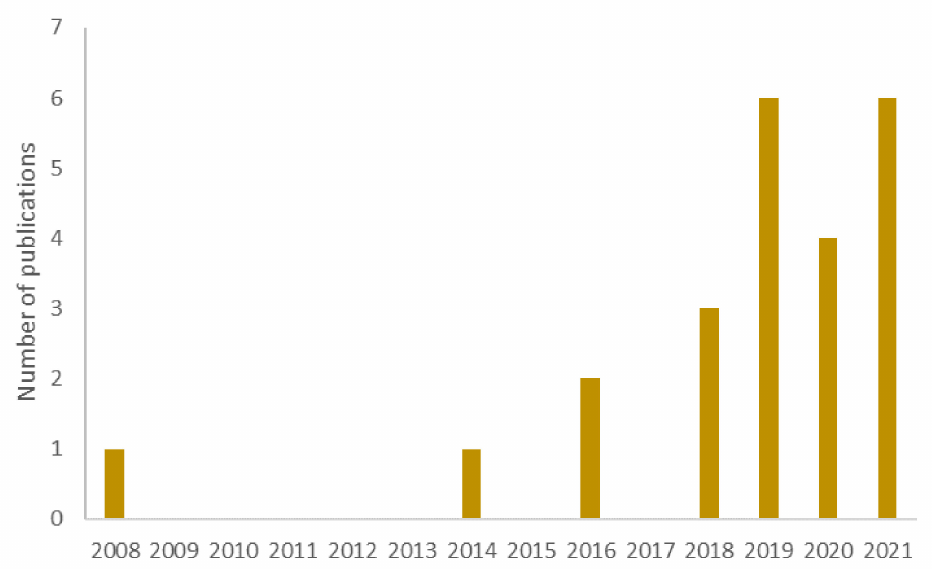
Figure 11. Number of publications based on UAV data in the analyzed multiyear